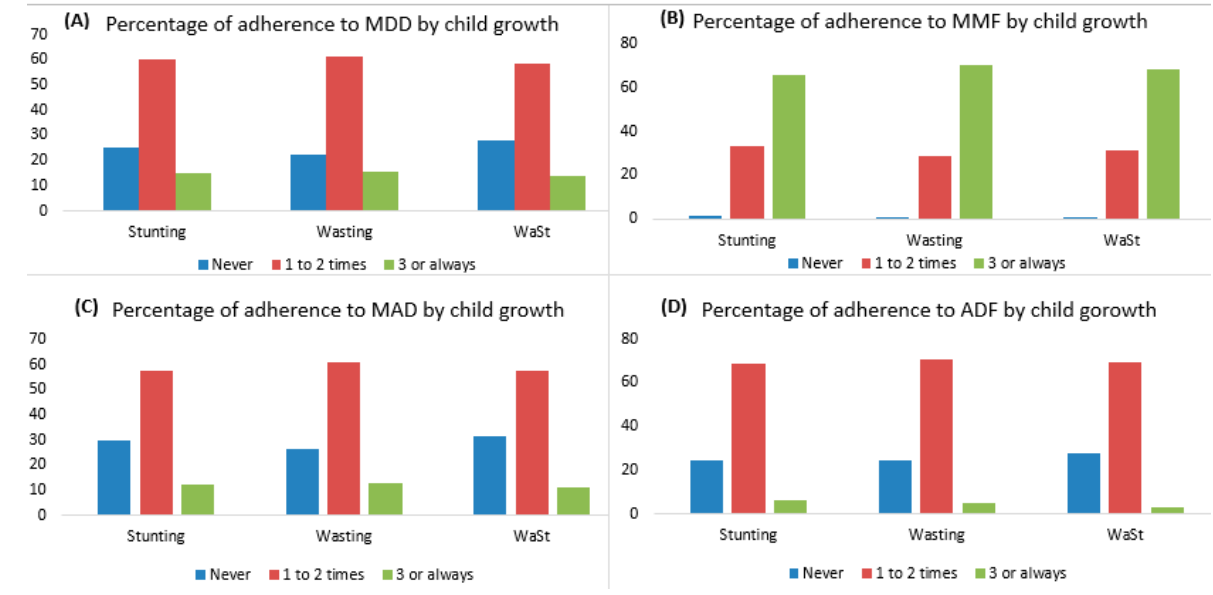
Figure 5. Percentage of adherence to age-appropriate feeding practices among children aged 0–23 months by their growth from the 1st to 6th follow-up. Stunting = height-for-age Z score < − 2 standard deviation; Wasting = weight-for-height Z score < − 2 standard deviation; and WaSt = concurrence wasting and stunting. MDD = minimum dietary diversity; MMF = minimum meal frequency; MAD = minimum acceptable diet; and ADF = age-appropriate daily feeding. ( A ) Percentage of total number of adherence to MDD by child growth; ( B ) Percentage of total number of adherence to MMF by child growth; ( C ) Percentage of total number of adherence to MAD by child growth; and ( D ) Percentage of total number of adherence to ADF by child growth.